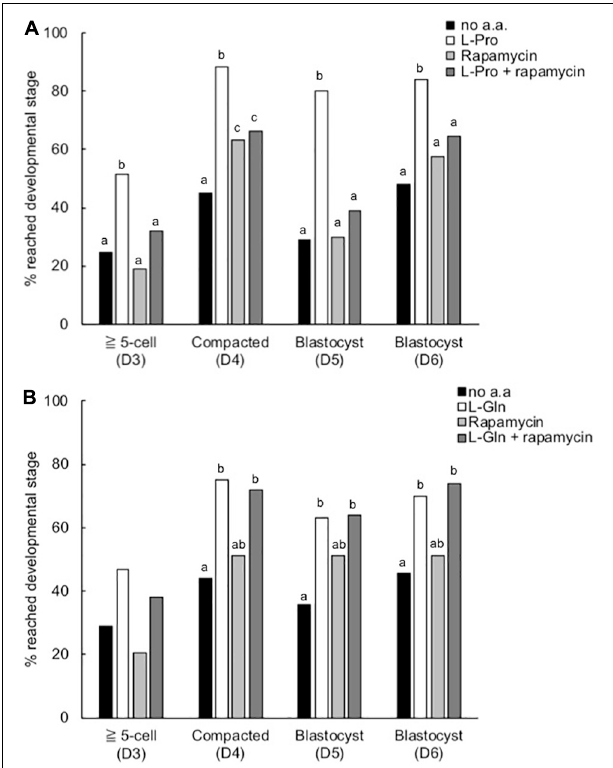
FIGURE 7 | Effect of rapamycin on the L-Pro- and L-Gln-mediated improvement in development of mouse embryos cultured in isosmotic (270 mOsm/kg) medium at LD. Zygotes (20–22 h post-hCG) were cultured for 5 days in no amino acids (no a.a.), 400 µ M L-Pro alone (A) , 1 mM L-Gln alone (B) , 10 nM rapamycin alone or 10 nM rapamycin in the presence of (A) 400 µ M L-Pro or (B) 1 mM L-Gln. The percentage of zygotes that developed to the designated stages over the 5 days was recorded. D indicates the day of development; embryos were analyzed from at least three independent biological replicates. Bars with different letters are significantly different within each day of development, determined using Fisher’s exact test, with Bonferroni correction for multiple comparisons ( P <